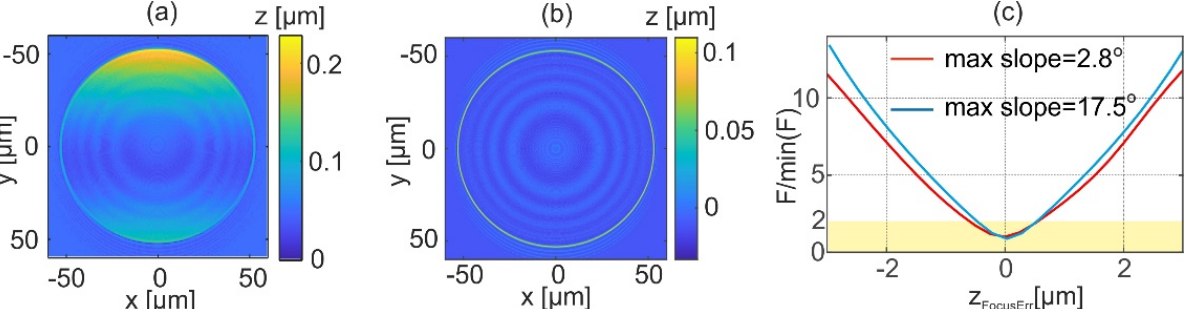
Figure 7. The difference of shapes obtained using LSF and TTEA for θ p = − 29° for defocus z d = − 1 μ m ( a ) and 0 μ m ( b ). The focus measurement for two different objects ( c ); the calculations performed for the geometrical frequency illumination scanning (Figure 3b).